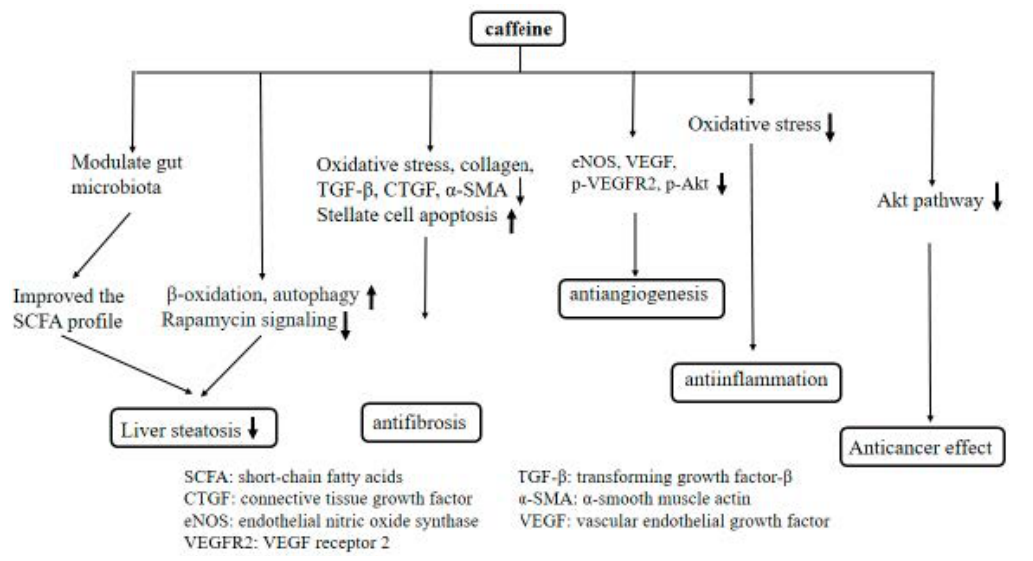
Figure 3. The postulated mechanisms regarding the effect of caffeine on the liver. Table 3. Emerging evidence of coffee or caffeine treatment on various lung